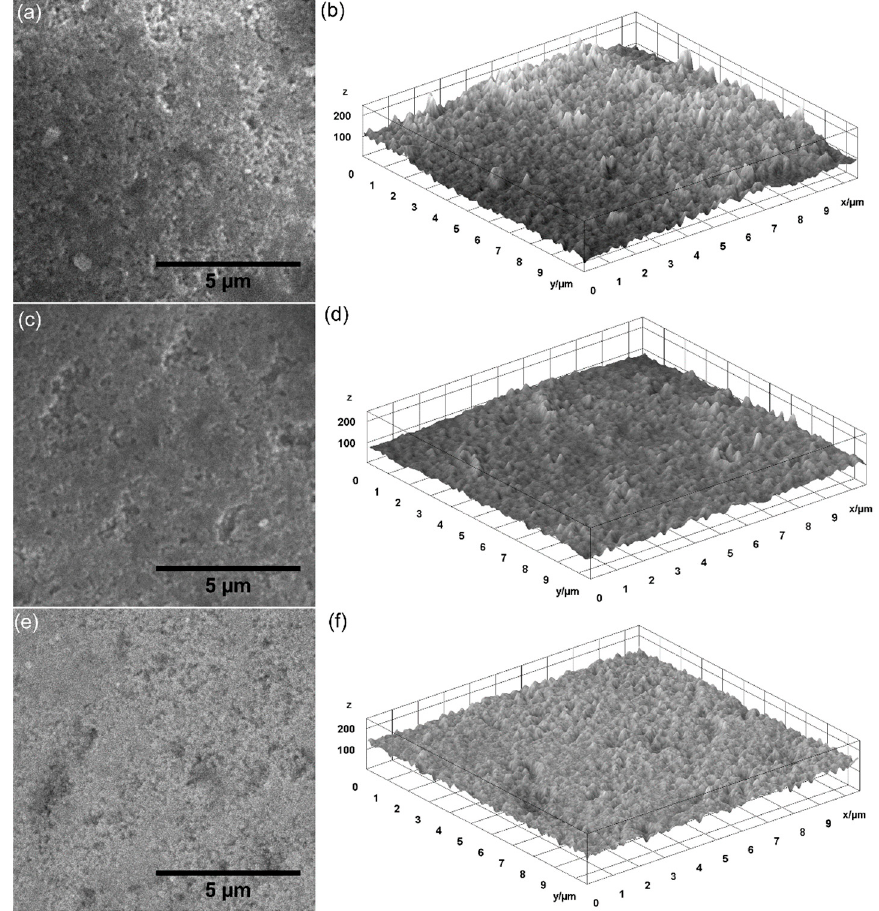
Figure 3. 2D SEM micrographs of HAp ( a ), 0.05 AgHAp ( c ), 0.1 AgHAp ( e ) coatings and 3D representation of SEM micrographs of HAp ( b ), 0.05 AgHAp ( d ), and 0.1 AgHAp ( f ) coatings.